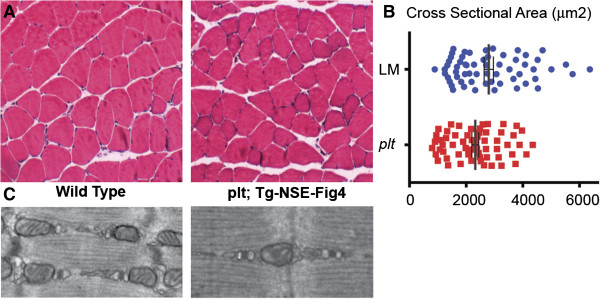
Transgenic (Tg) neuronal rescue of FIG4 expression largely restores plt myofiber size. (A) Hematoxylin and eosin–stained sections of gastrocnemius muscle from wild-type (WT) and Fig4−/−/NSE-FIG4 (that is, plt with transgenic expression of Fig4 driven by the neuron-specific enolase (NSE) promoter). The plt muscle is essentially indistinguishable from WT, with the exception of mild reduction in fiber size. (B) Quantification of myofiber size from quadriceps muscles of 8-month-old Fig4−/−/NSE-FIG4 and WT animals. There was a small but significant reduction in total fiber area in transgenically rescued plt muscle: 2,799 μm2 ± 165 for WT vs 2,322 μm2 ± 121 for plt (n = 60, P = 0.02). (C) Transmission electron photomicrographs from tibialis anterior muscle. Normal triads and mitochondria were present in both WT and plt/Tg-NSE-Fig4 animals.